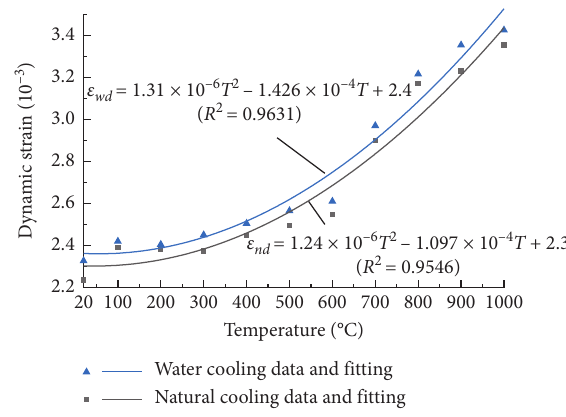
Figure 10: Dynamic strain of high temperature sandstone after two cooling methods.